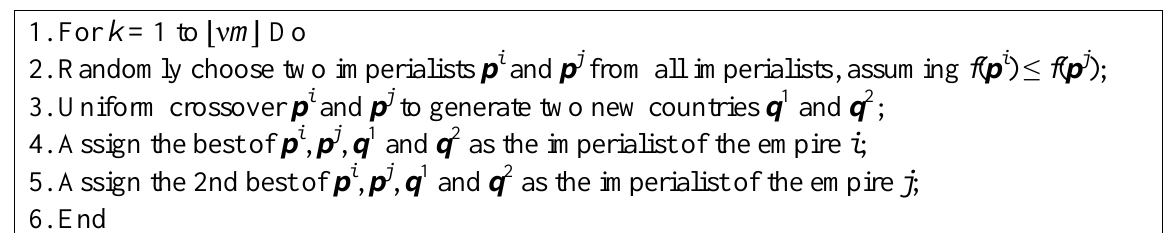
Figure 4. Interaction using Crossover